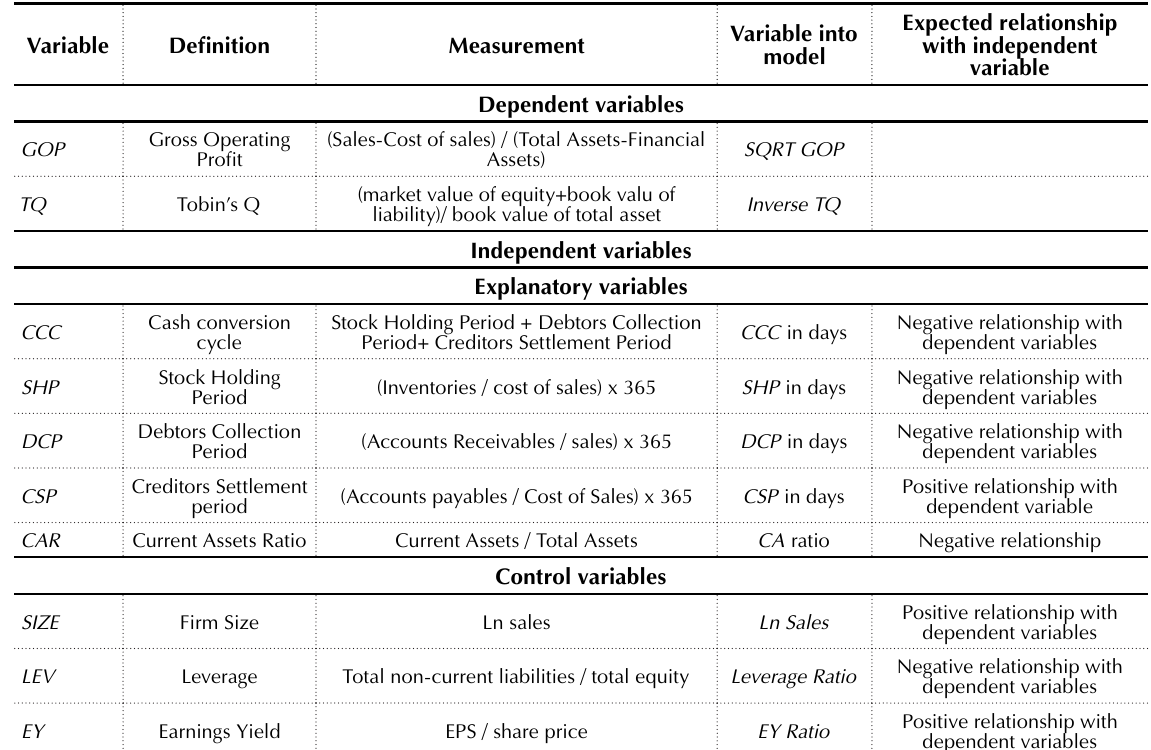
Table 2. Summary of